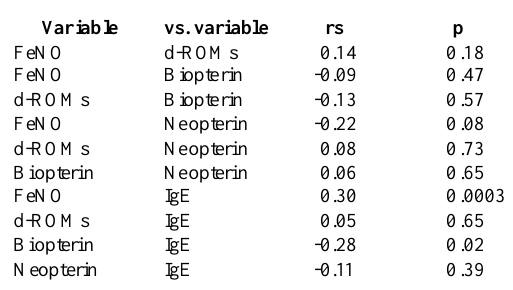
Table 2.: Multivariate analysis